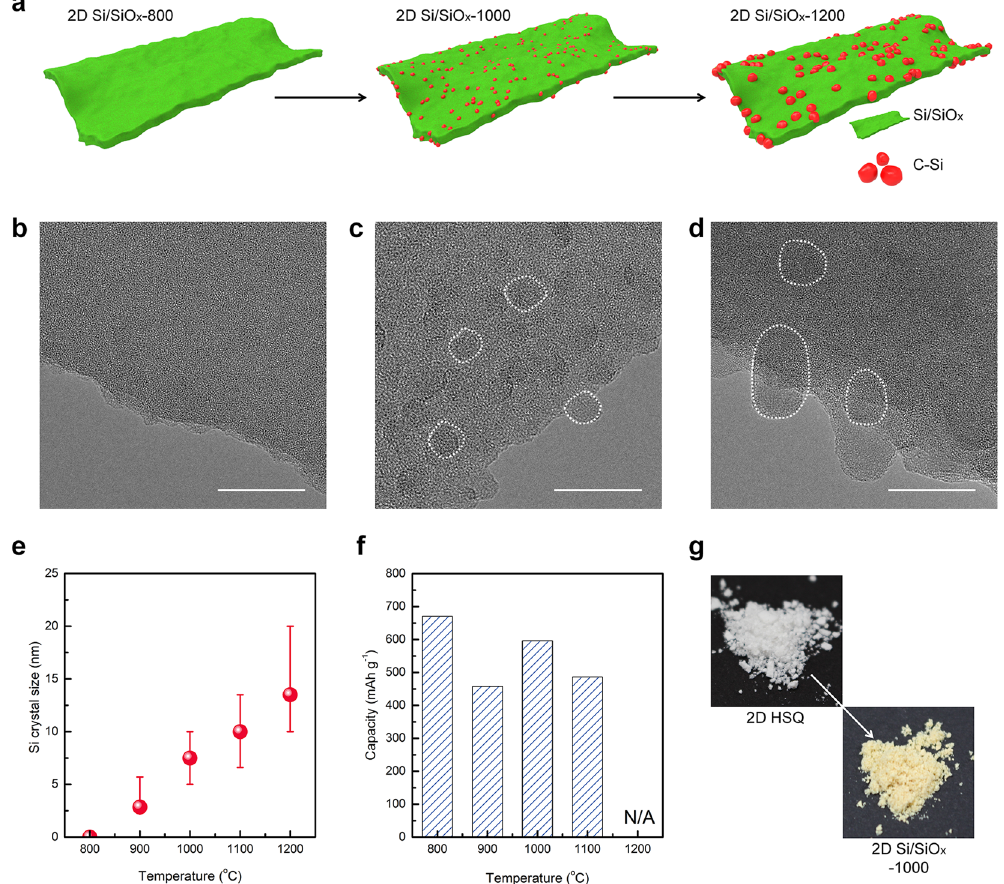
Figure 3. Structural characterization of 2D Si/SiO x nanofoils obtained by heat treatment at various temperatures. ( a ) Schematic diagram of various 2D Si/SiO x nanofoils, HRTEM images of 2D Si/SiO x